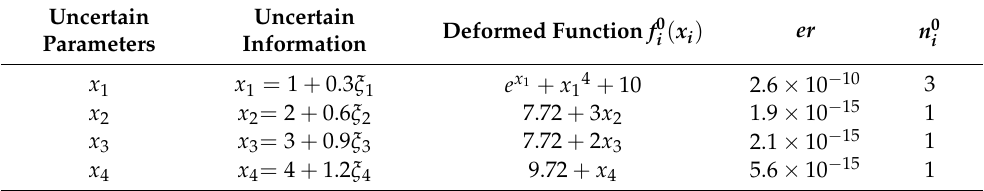
Table 1. Uncertainty information and deformed function of each uncertain parameter.